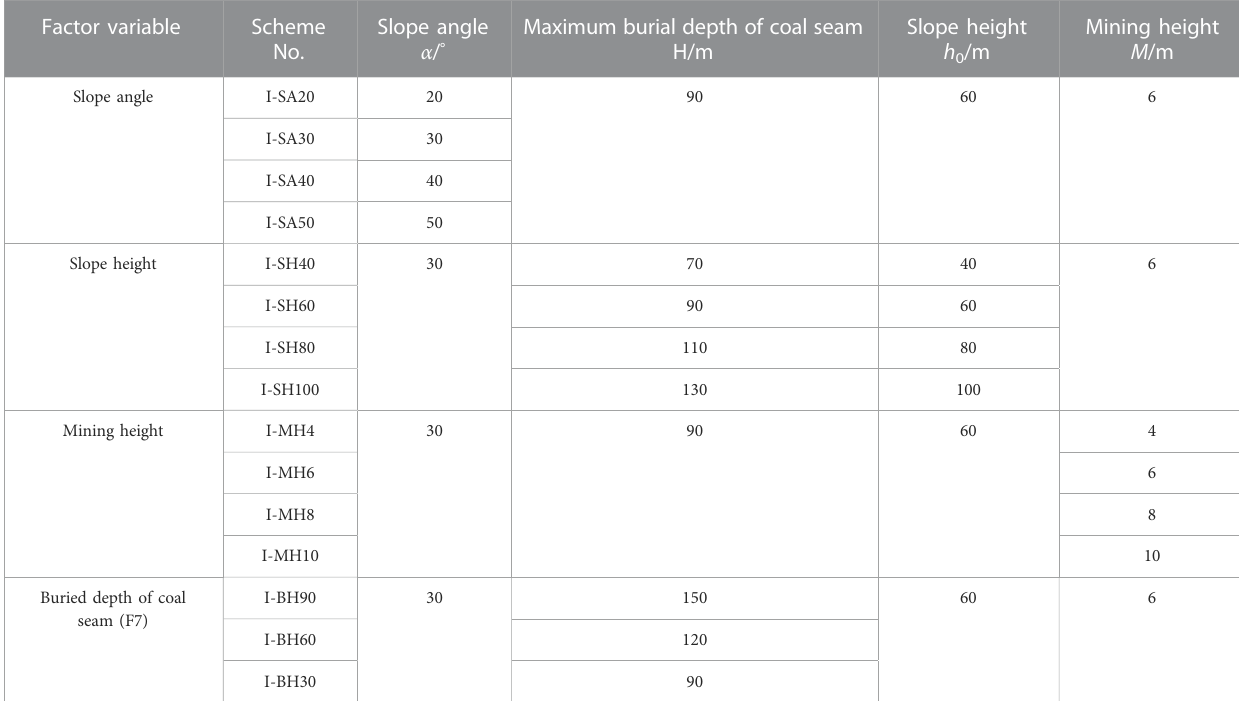
TABLE 3 Experimental model scheme for Class I